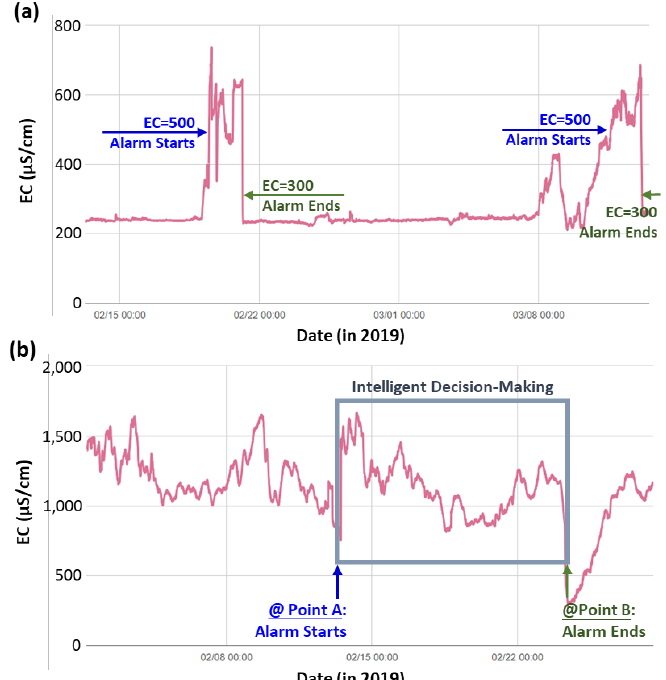
Figure 5. Threshold management of the measured EC values ( a ) for source-water type monitoring station at Taoyuan, and ( b ) for ditch-water type monitoring station at No. 25-3 Water Guide Station in Taoyuan Sanquaichuo Branch.